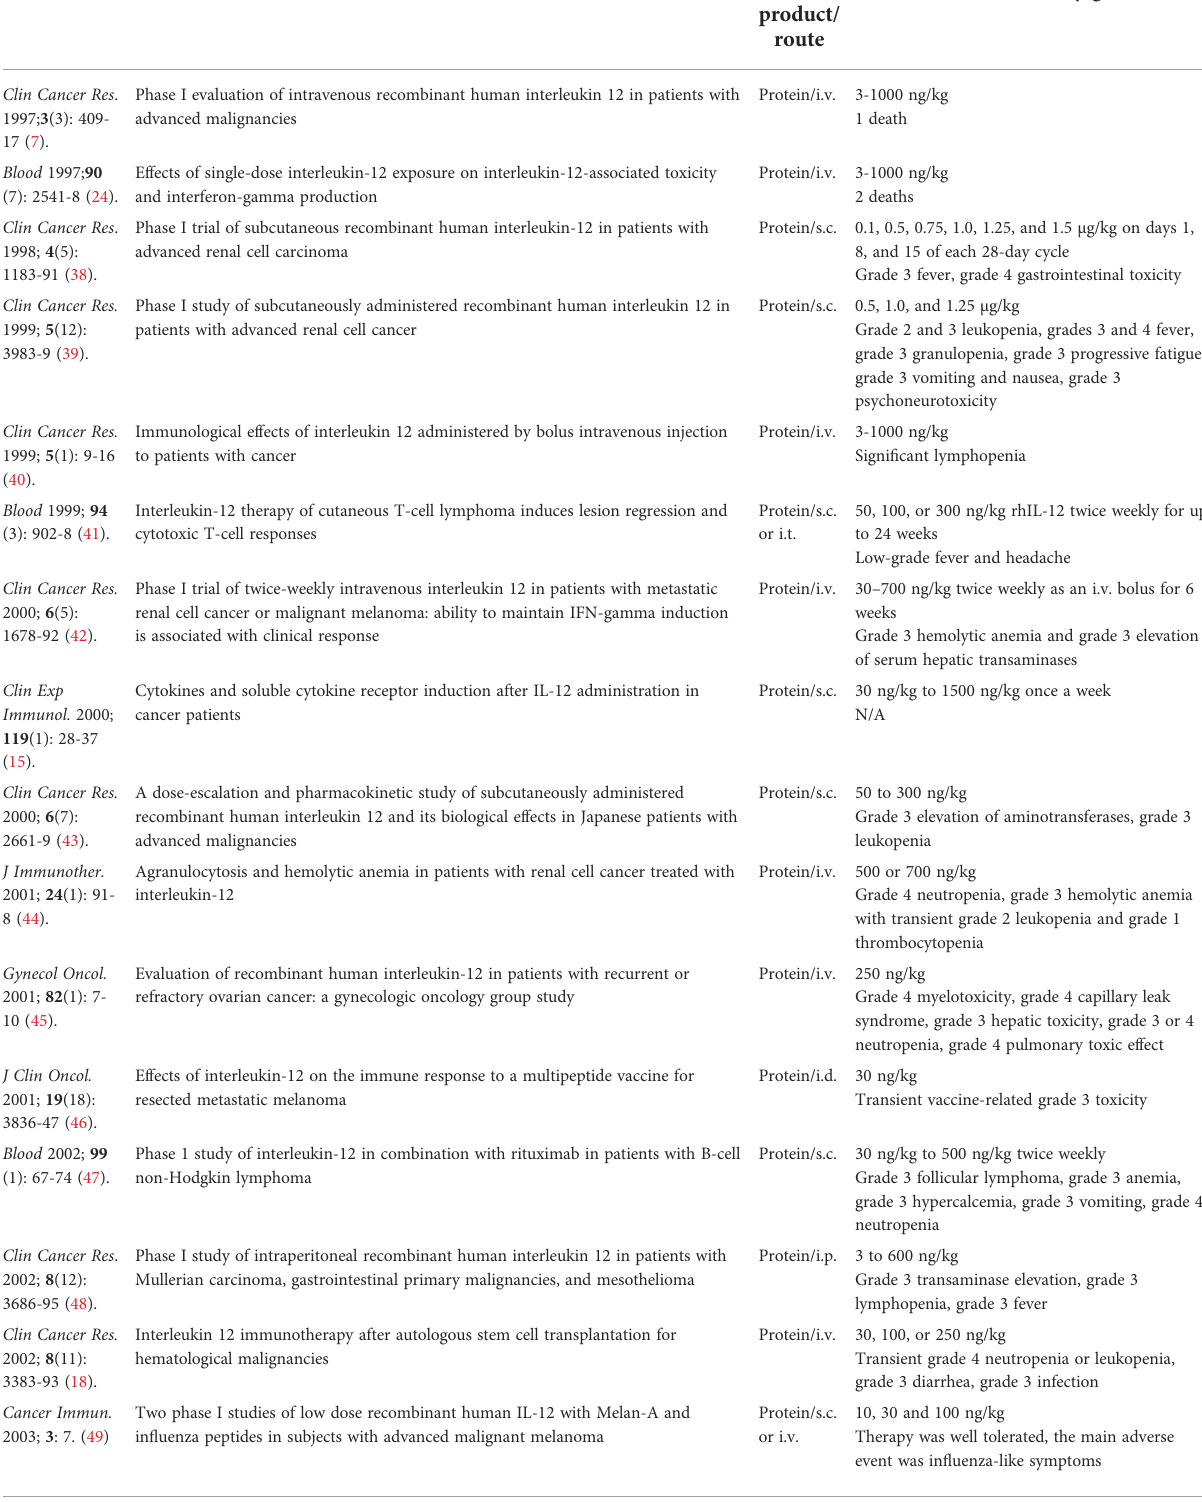
TABLE 1 Summary of human clinical trials of wild-type IL-12 protein therapy.